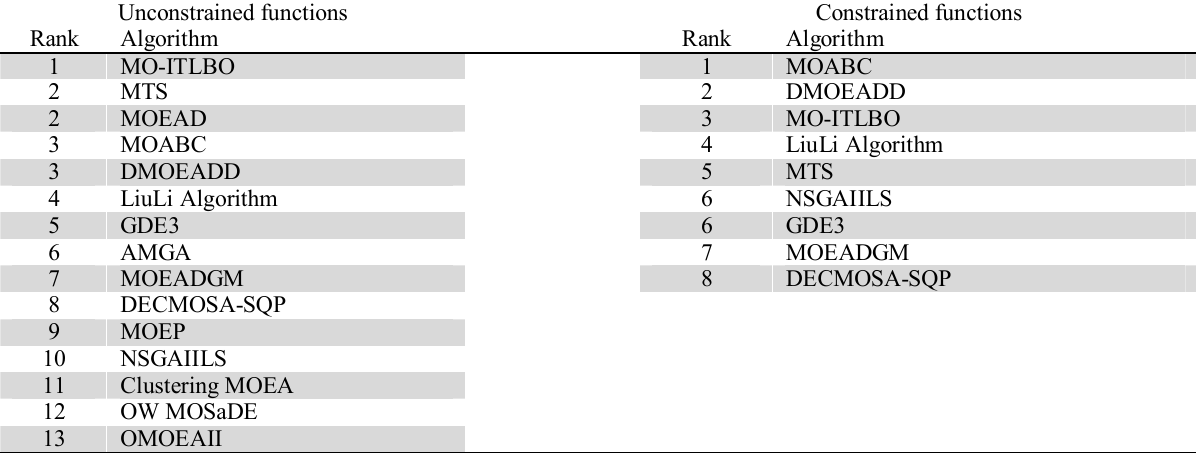
The Lexicographic ordering of the unconstrained and constrained test problems Unconstrained functions Constrained